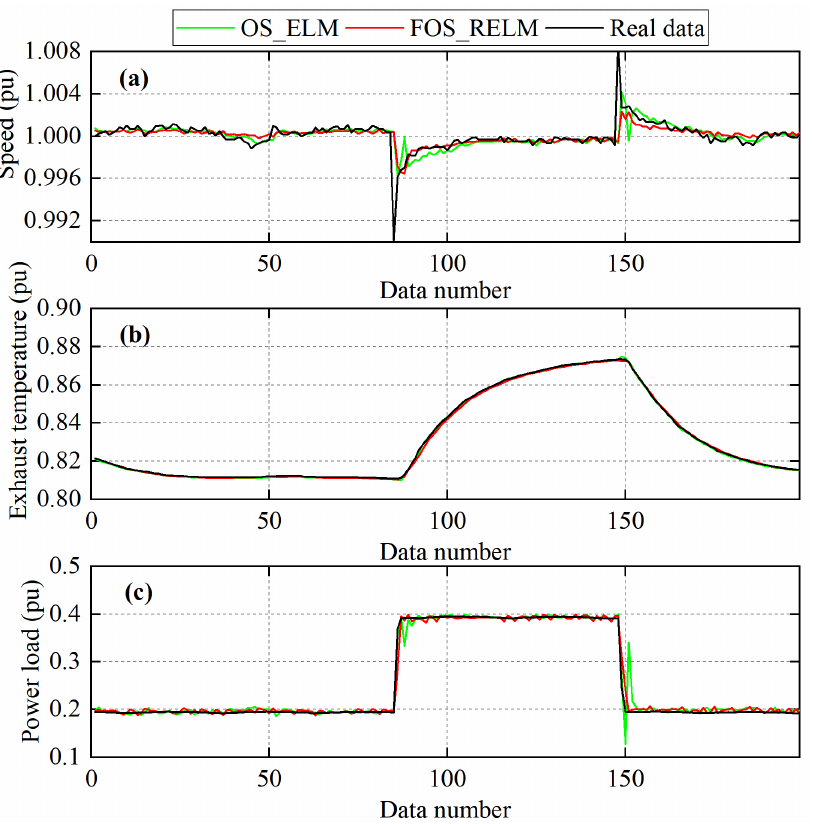
Figure 11. The modeling results with OS_ELM and FOS_RELM under different environmental con- ditions: ( a ) Speed signal. ( b ) Exhaust temperature signal. ( c ) Power load signal. conditions: ( a ) Speed signal. ( b ) Exhaust temperature signal. ( c ) Power load